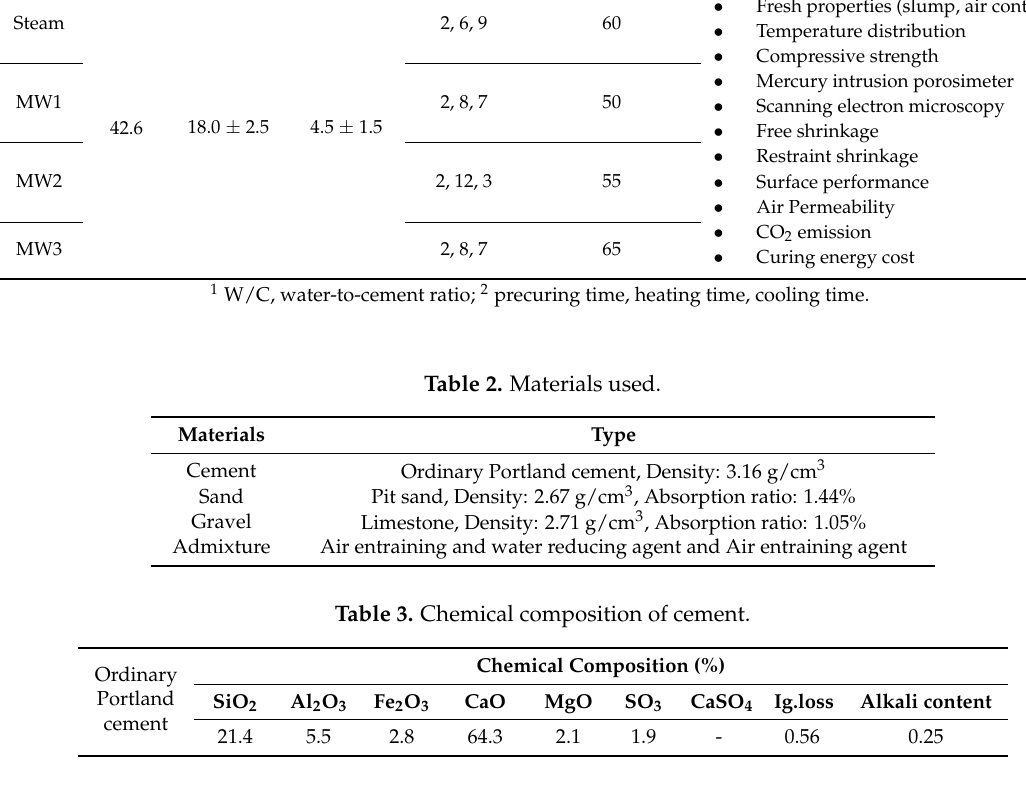
Table 4. Concrete mix